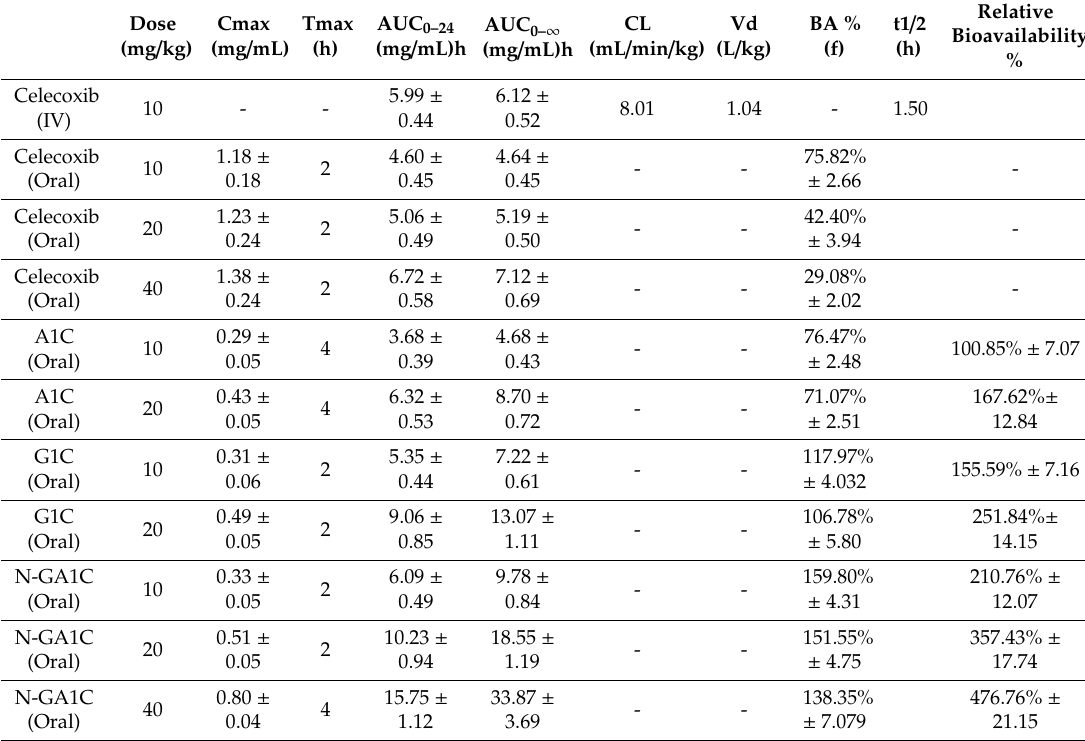
Table 2. Pharmacokinetic profiles of celecoxib, A1C, G1C, and N-GA1C. Absolute bioavailability and relative bioavailability were calculated using the following equations: Absolute bioavailability (F, %) = [(AUC / dose PO] / [(AUC / dose IV]; Relative bioavailability (%) = [(AUC0– ∞ )A / dose 0– ∞ )PO 0– ∞ )IV A] / [(AUC 0– ∞ )B / dose